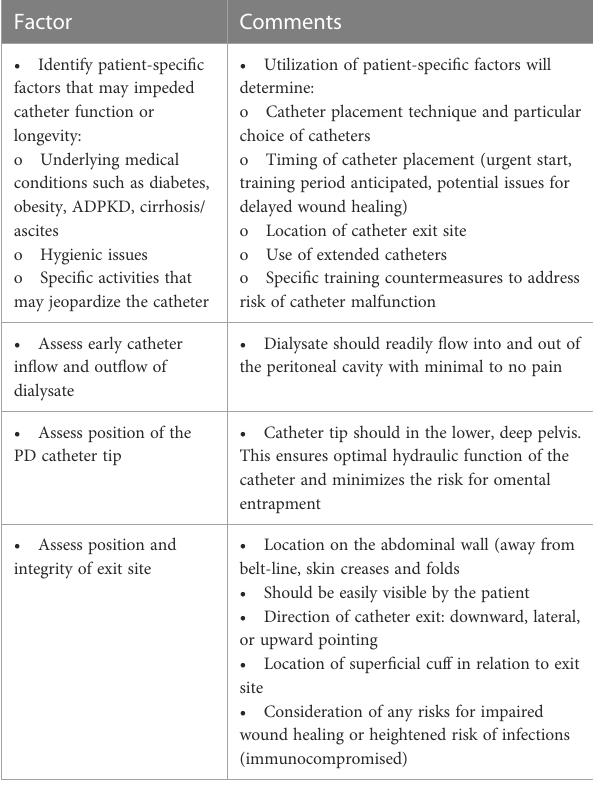
TABLE 1 Factors to consider monitoring to ensure optimal pd catheter function and longevity.